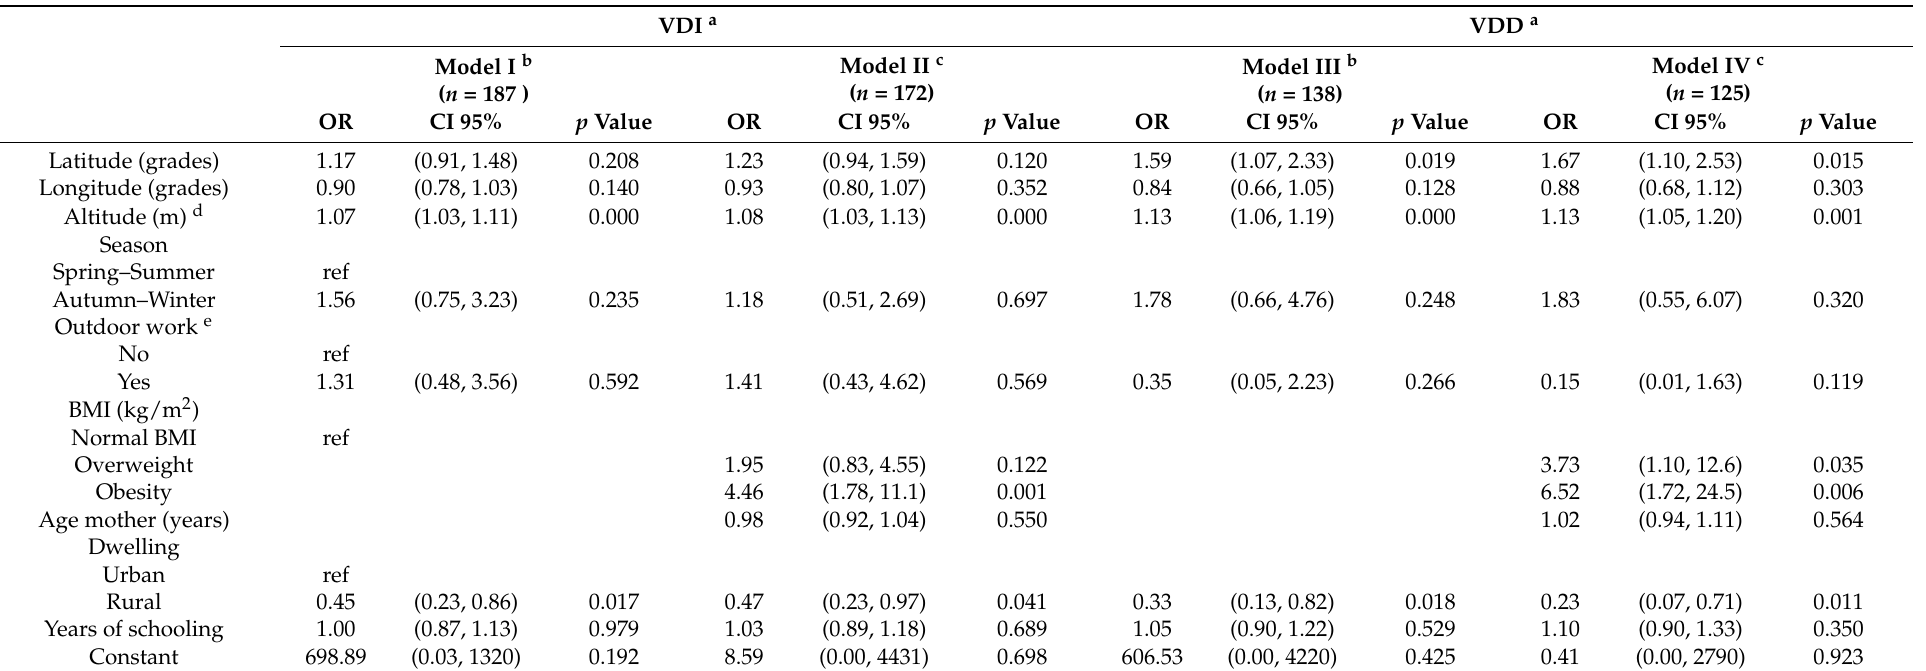
Table 3. Prediction of serum vitamin D using DF and PF determinants in women. ENSANUT